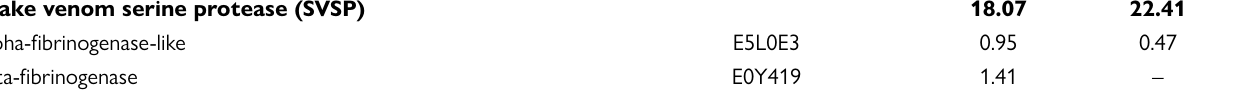
Protein family and subtype